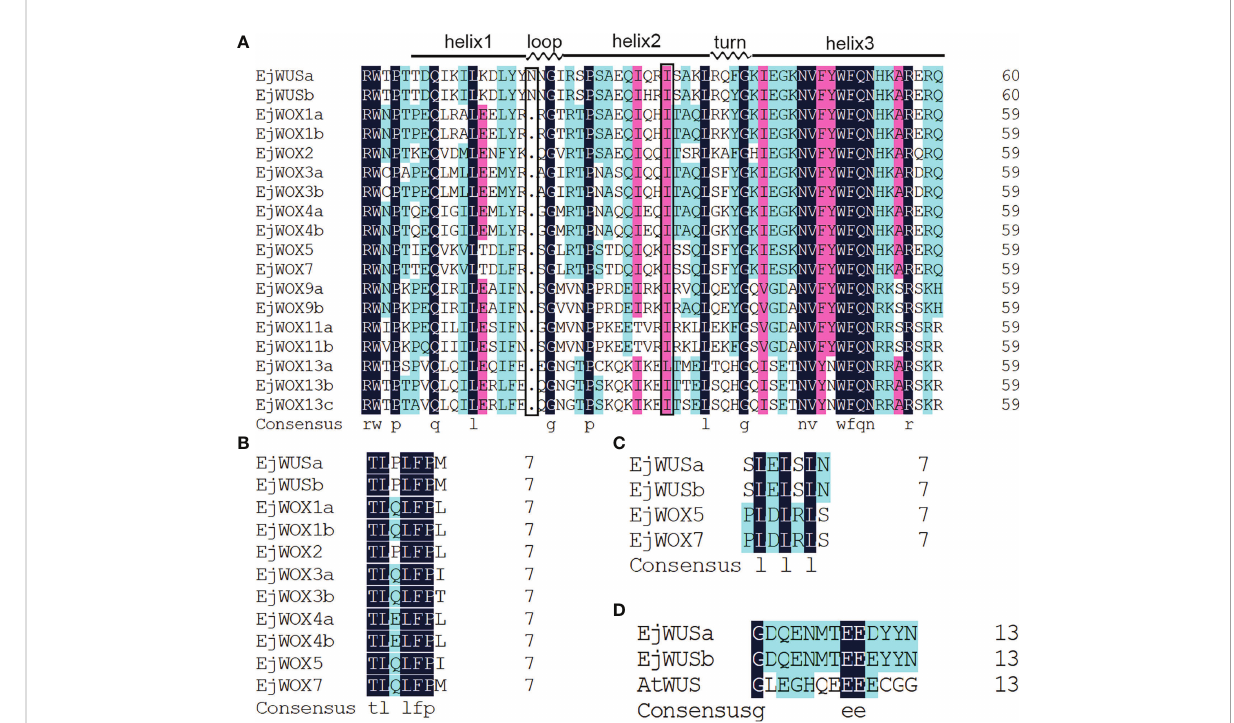
FIGURE 2 Multiple sequence alignment of WOX proteins in loquat. (A) Multiple sequence alignment of the homeodomain. An extra amino acid residue in the black box was observed in the homeodomain of the EjWOX proteins within the WUS subgroup. (B) Multiple sequence alignment of the WUS-box. (C) Multiple sequence alignment of the EAR-like motif. (D) Multiple sequence alignment of the acidic region. The identical residues are in black